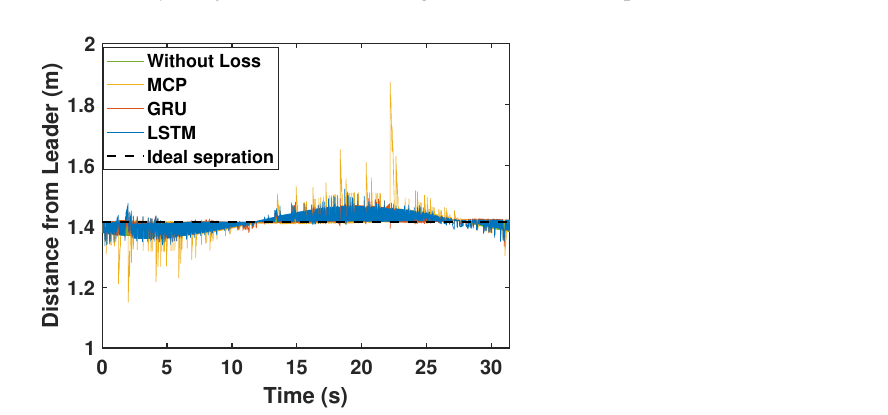
Figure 8. Trajectory of the robots during formation control (packet loss—30%).